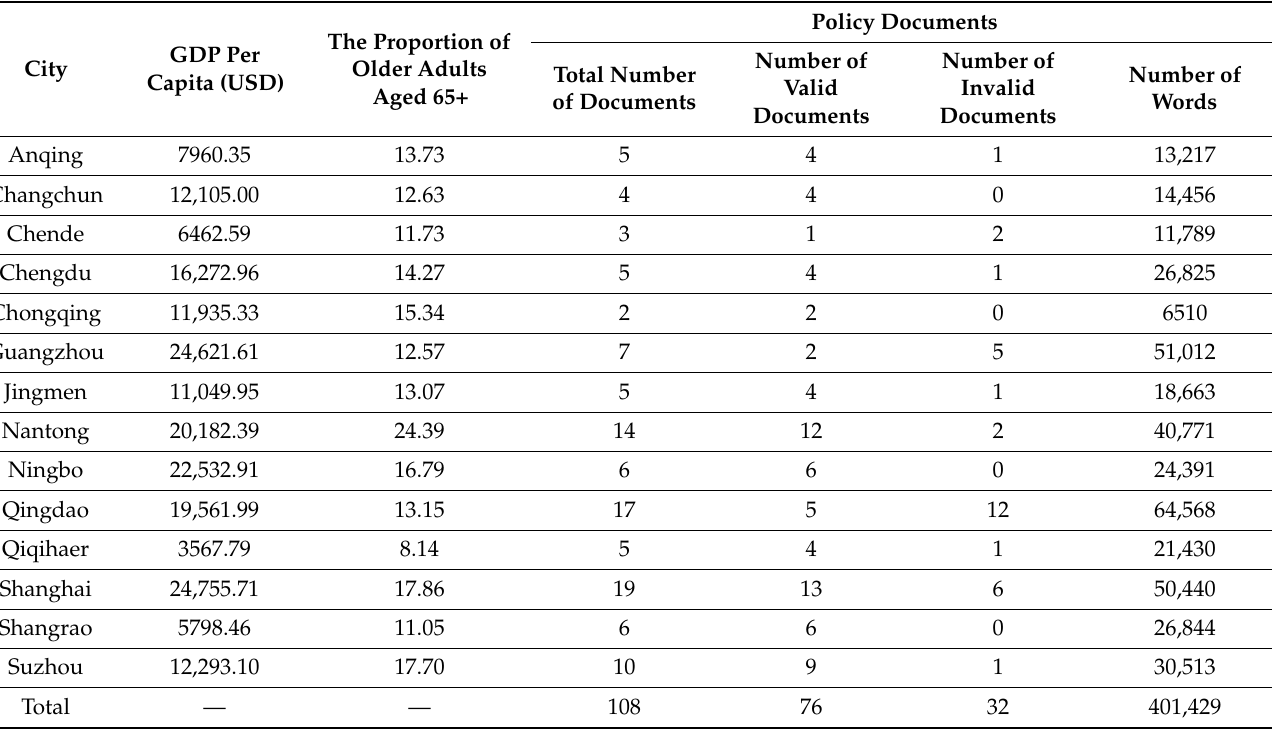
Table 2. Descriptions of the local economy, aging population, and policy documents of 14 pilot cities in